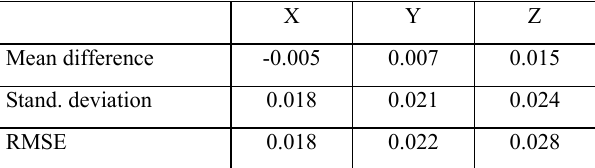
Table 1 Assessment of check points measurements